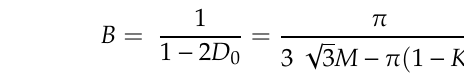
π to π ), k = 𝑡𝑜 𝜋 ), k = 0.5. 6 2 6 2